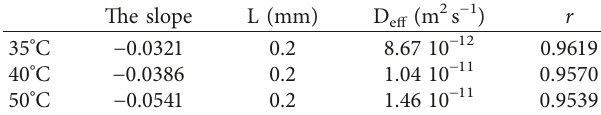
Figure 6: The values of MR predicted by the Middili–Kucuk model as function of its experimental data. Table 4: Values of the effective diffusivity for three drying air temperatures.